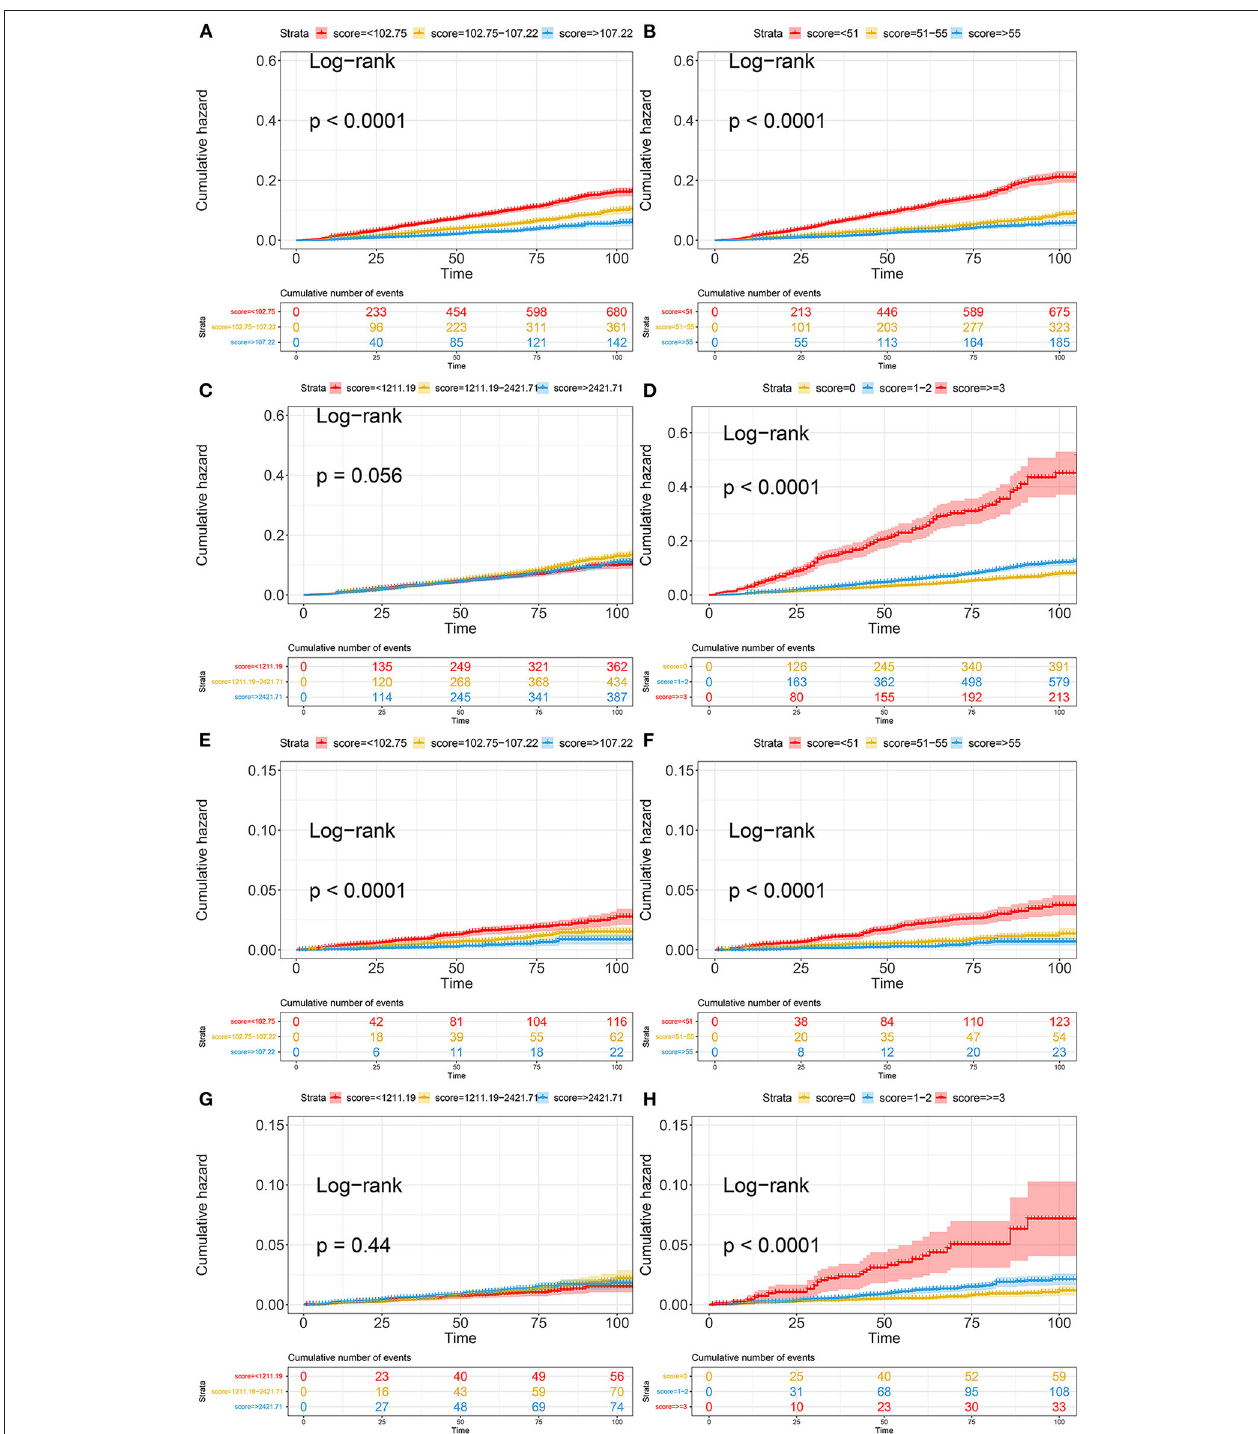
FIGURE 3 | Kaplan-Meier curves of all-cause death and cardiovascular death based on four nutritional scores. (A) Kaplan-Meier curves of all-cause death categorized by GNRI; (B) Kaplan-Meier curves of all-cause death categorized by PNI; (C) Kaplan-Meier curves of all-cause death categorized by TCBI; (D) Kaplan-Meier curves of all-cause death categorized by COUNT score; (E) Kaplan-Meier curves of cardiovascular death categorized by GNRI; (F) Kaplan-Meier curves of cardiovascular death categorized by PNI; (G) Kaplan-Meier curves of cardiovascular death categorized by TCBI; (H) Kaplan-Meier curves of cardiovascular death categorized by COUNT score. PNI, Prognostic Nutritional Index; GNRI, Geriatric Nutritional Risk Index; CONUT score, Controlling Nutritional Status score; TCBI, Triglycerides × Total Cholesterol × Body Weight Index.